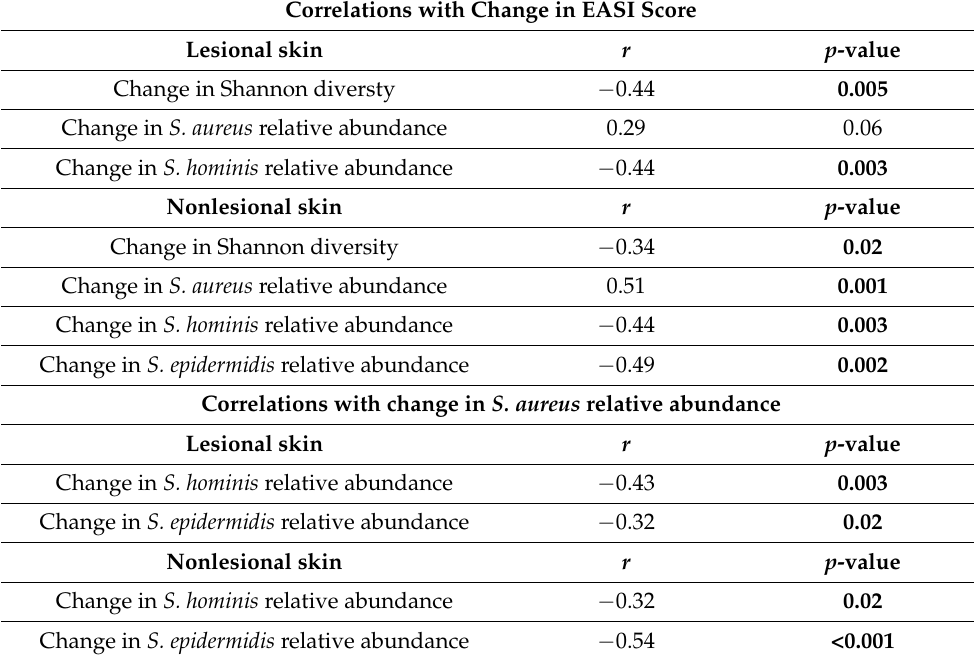
Table 3. Correlations between the skin microbiome and severity, clinical improvement, and changes in S. aureus